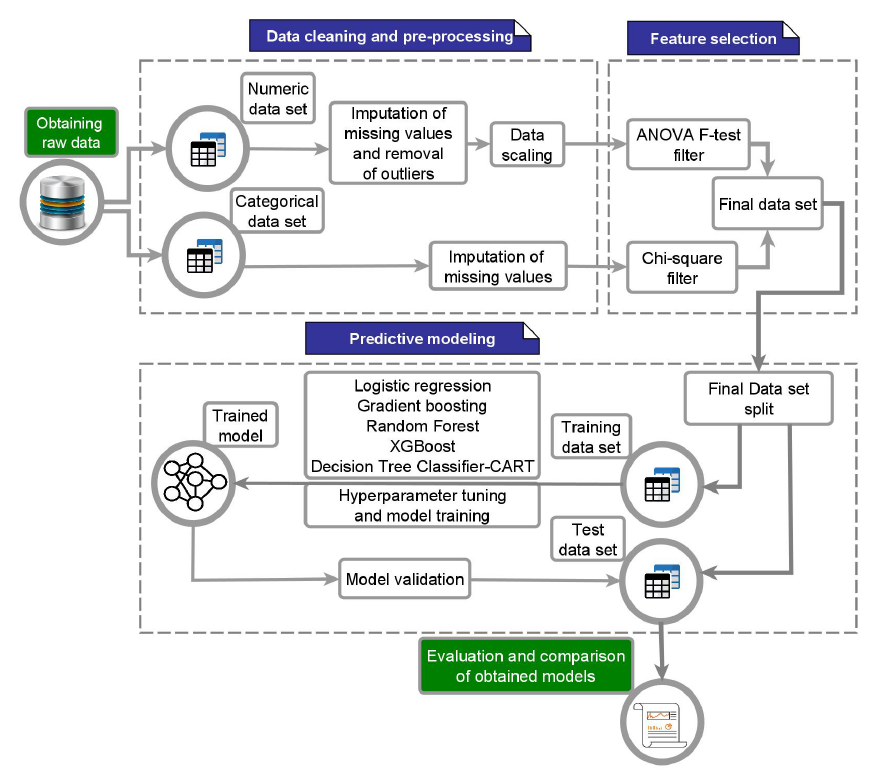
Figure 1. Proposed methodology for modeling teacher job satisfaction.